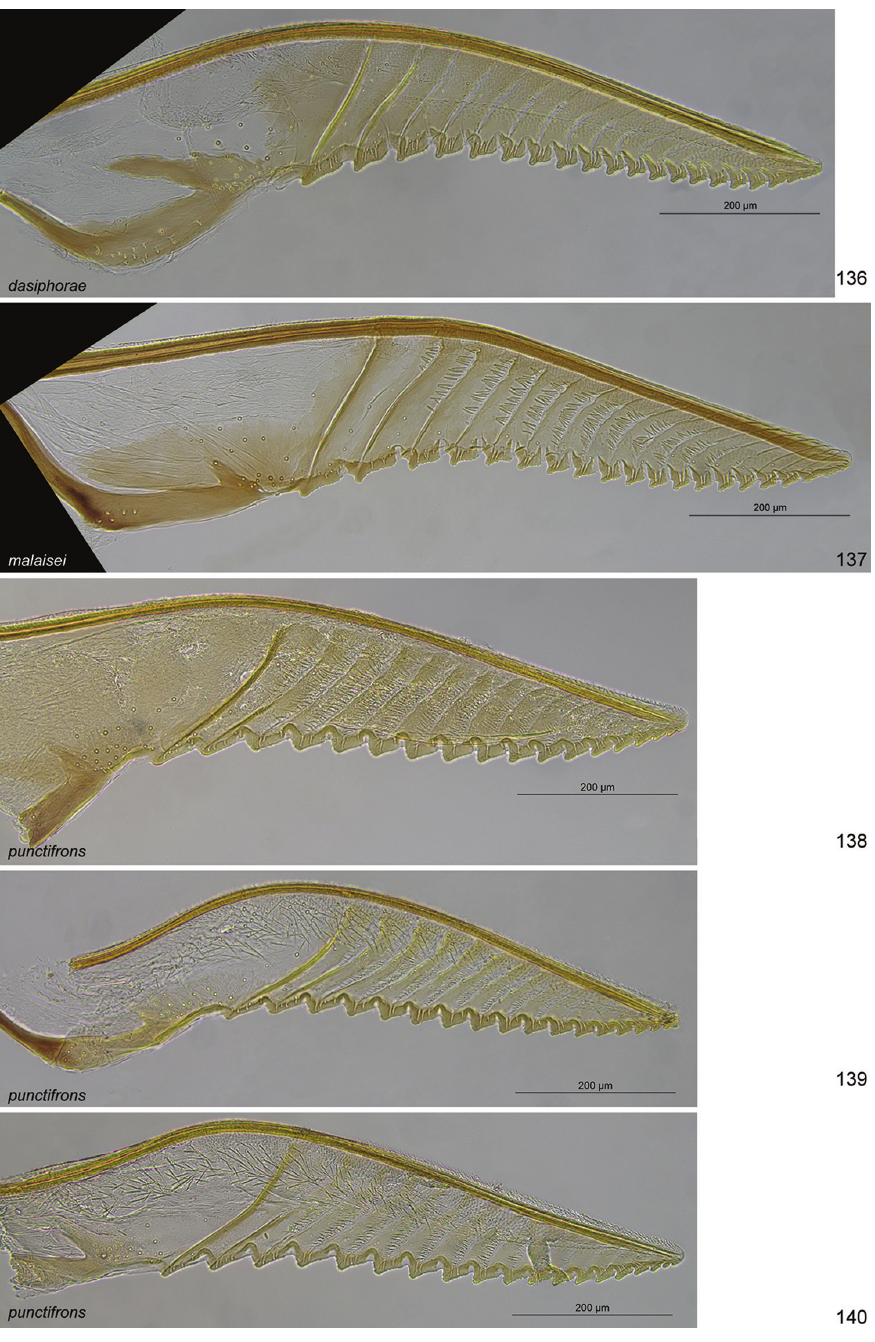
Figures 136–140. Lancets of Pristiphora . 136 dasiphorae DEI-GISHym31598 137 malaisei PR.641VV 138 punctifrons DEI-GISHym20878 139 punctifrons DEI-GISHym31578 140 punctifrons , holotype of flavipicta